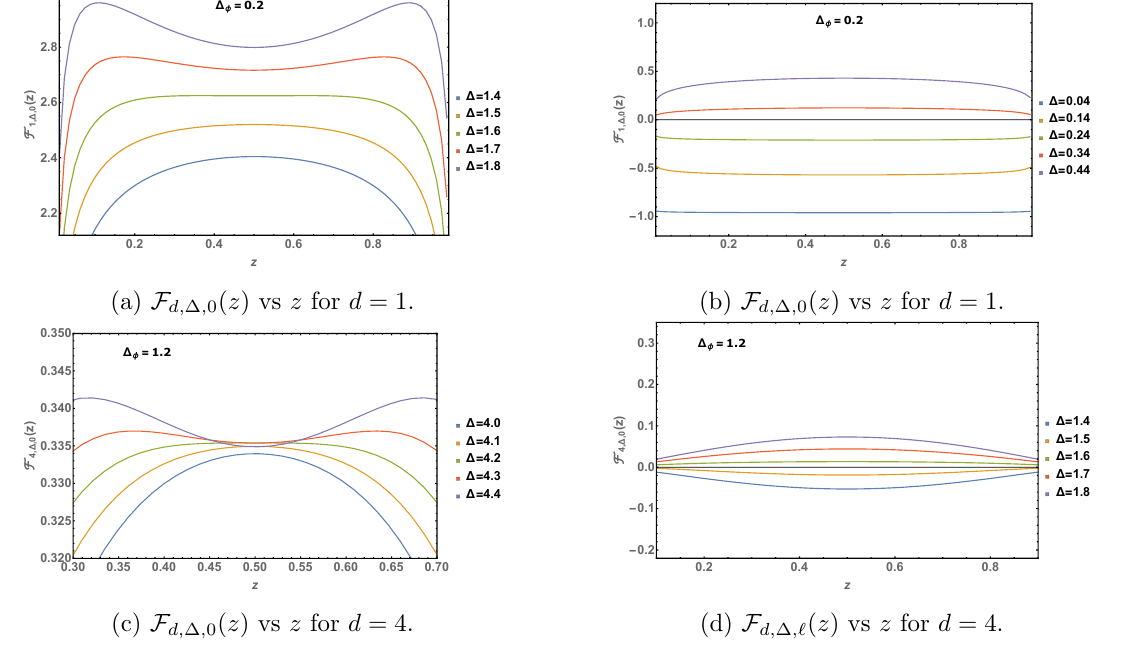
Figure 7. F d; (cid:1) ; 0 ( z ) vs z to show (cid:1) + and (cid:1) (cid:0) from numerical